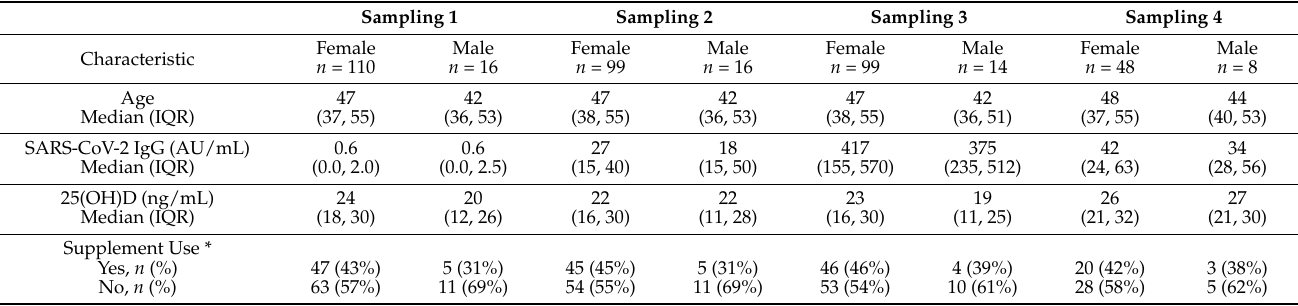
Table 1. Patient characteristics at each sampling time